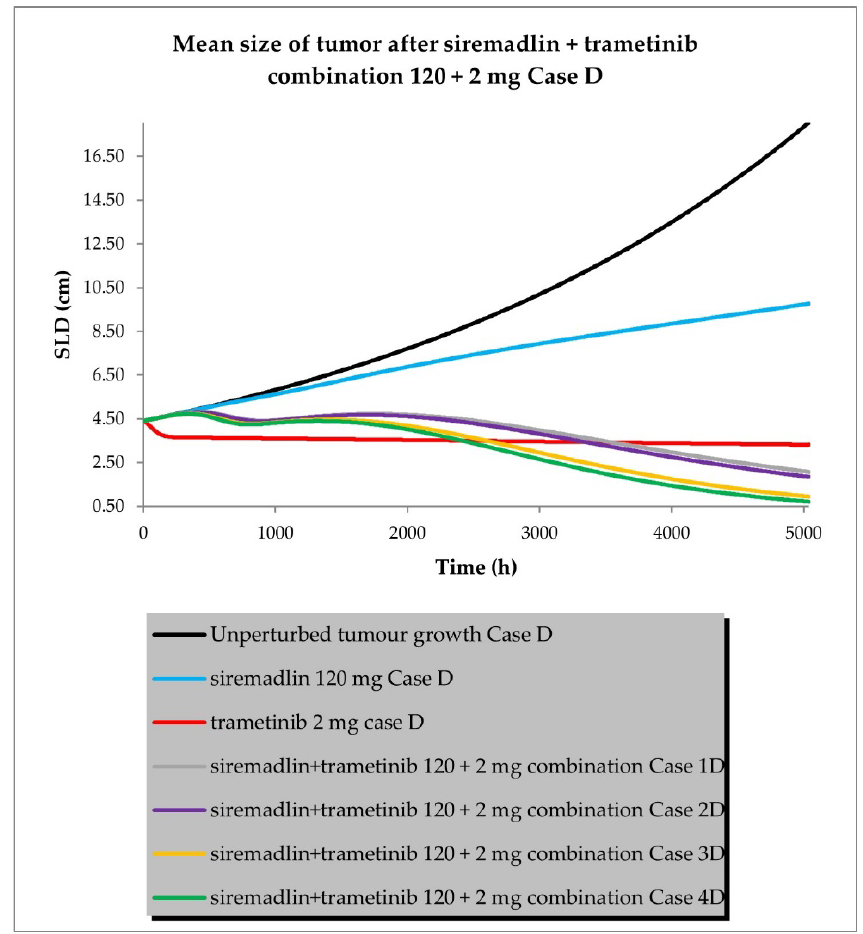
Figure 13. Siremadlin and trametinib combination’s 120 + 2 mg efficacy in population representative of melanoma cancer (Case D—high tumour growth, low initial tumour size, and high fraction of sensitive cells).